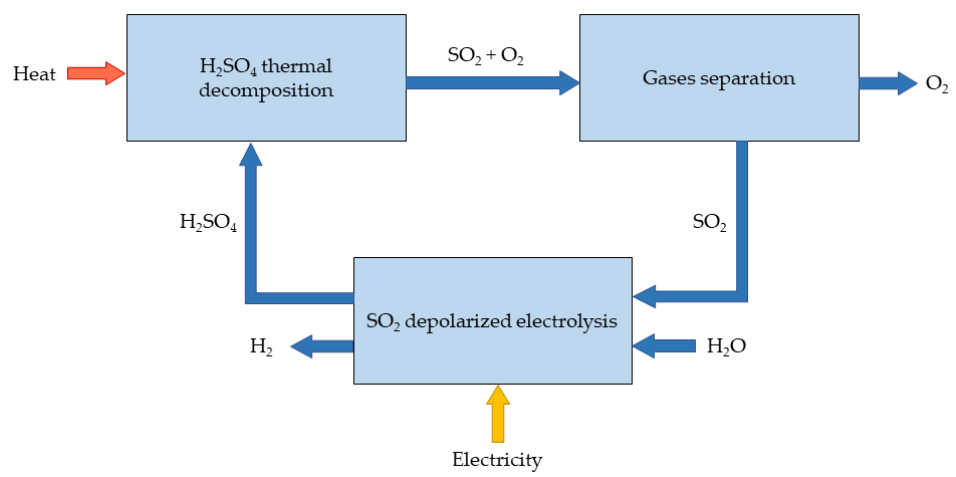
Figure 1. Westinghouse cycle scheme.